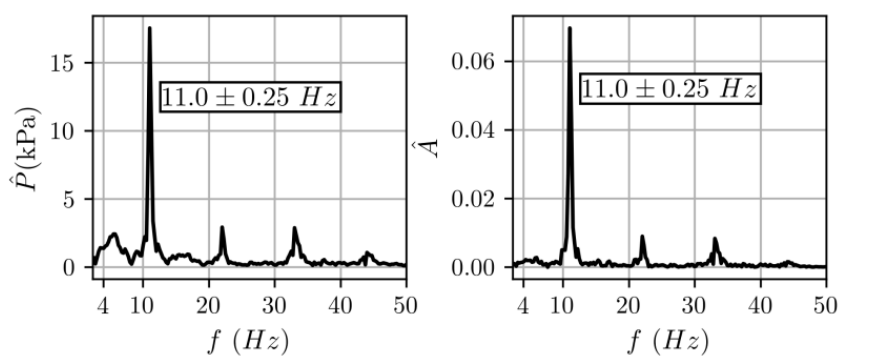
Figure 5. Frequency content for the last stable operating point and for an IGV stagger angle of 0 ◦ : unsteady pressure average spectrum ( left ) and unsteady alternate rate spectrum ( right